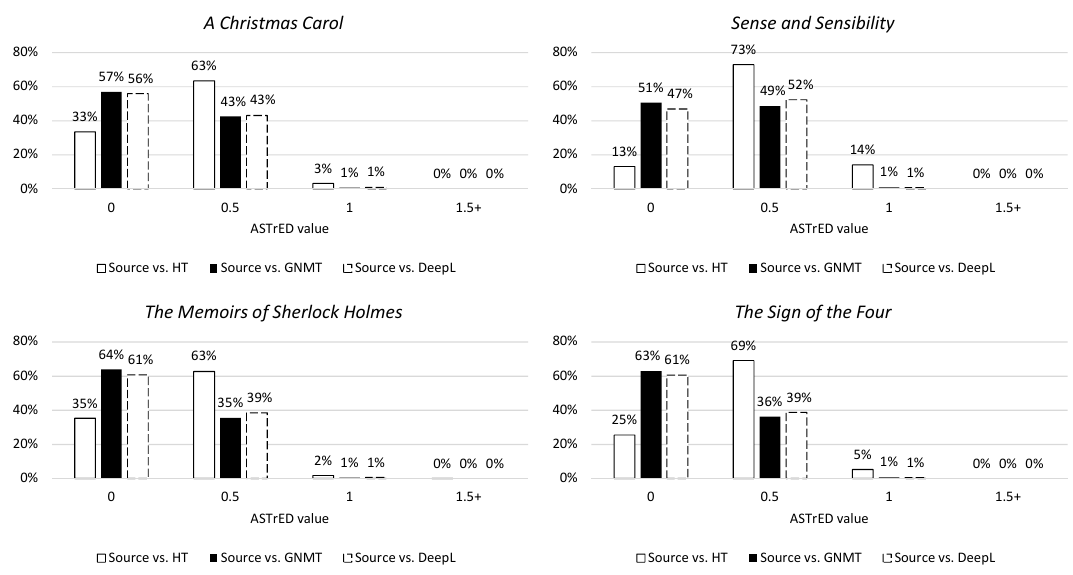
Figure 12. Distribution of ASTrED values in percentages per novel. The 0 column contains values [0:0.5[, the 0.5 column [0.5:1[,